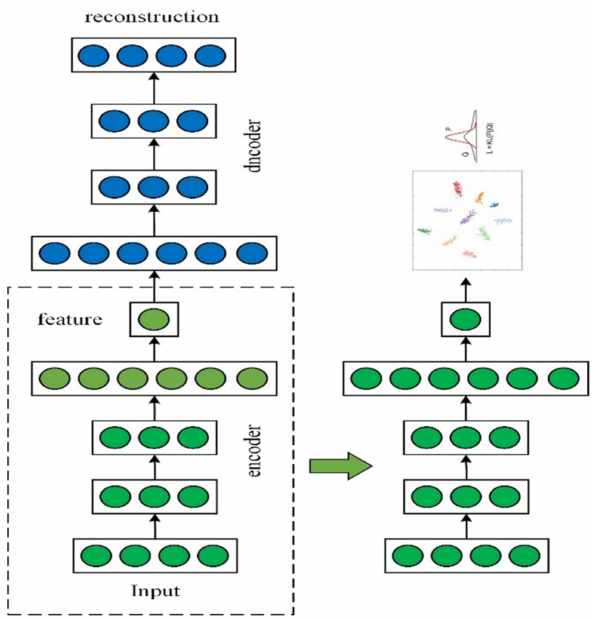
Figure 4. The principle of the DEC algorithm